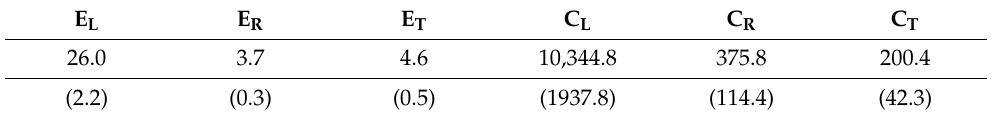
Table 1. Mechanical properties of Yunnan pine (unit: Mpa).